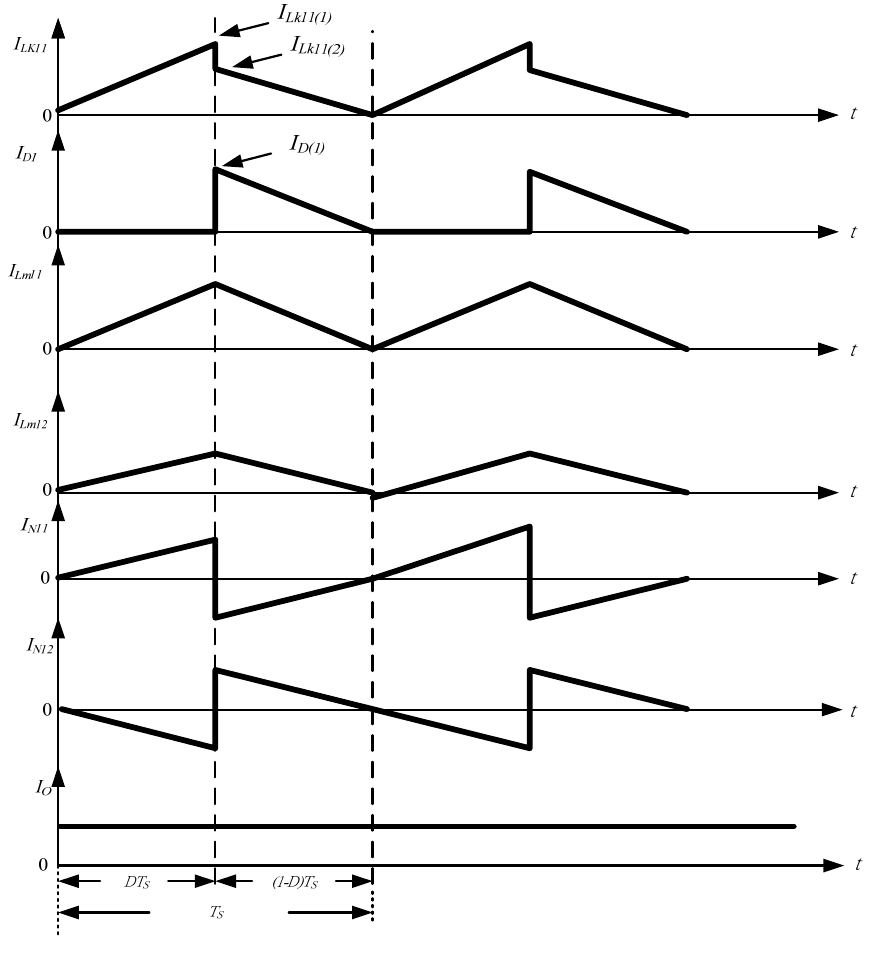
Figure 17. Conceptual current waveforms of inductor currents and output current in the proposed converter operated at the boundary of CCM and